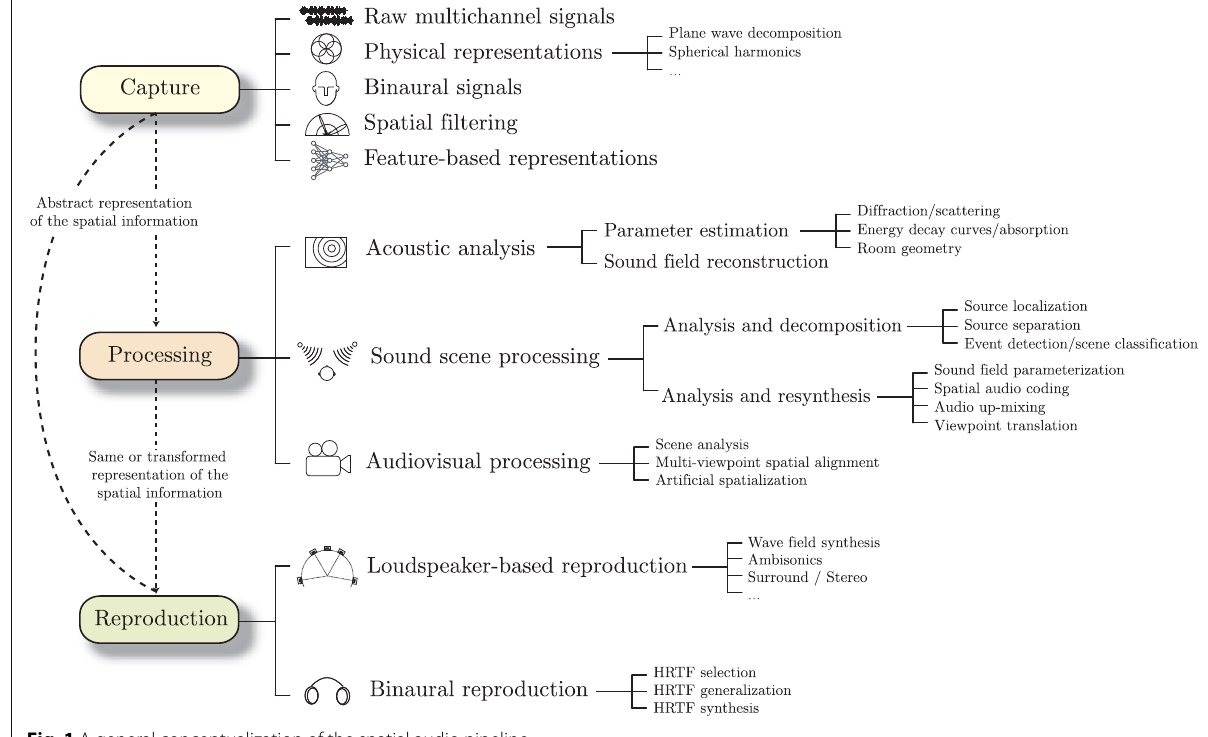
Fig. 1 A general conceptualization of the spatial audio pipeline